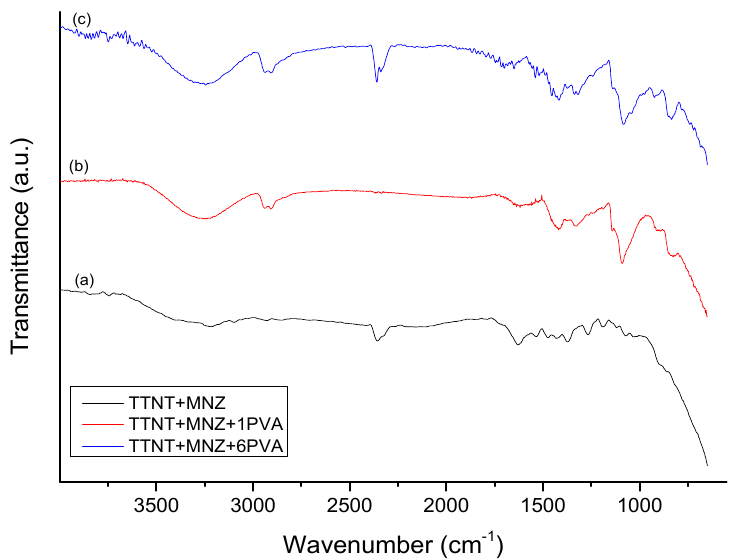
Figure 9. FTIR spectra of TTNT samples loaded with metronidazole: (a) TTNT+MNZ, (b) TTNT + MNZ + 1PVA and (c) TTNT + MNZ + 6PVA.